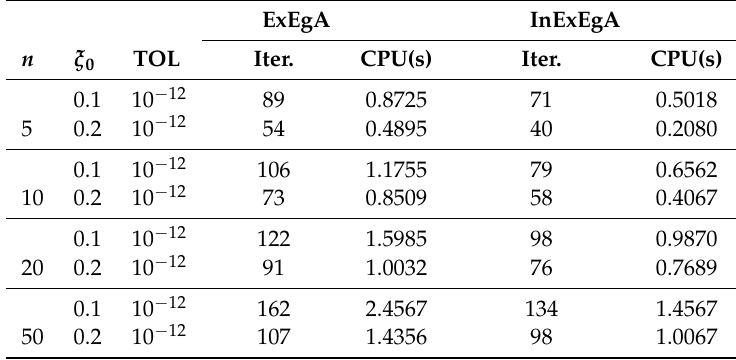
Table 1. Example 1: The numerical results for Figures